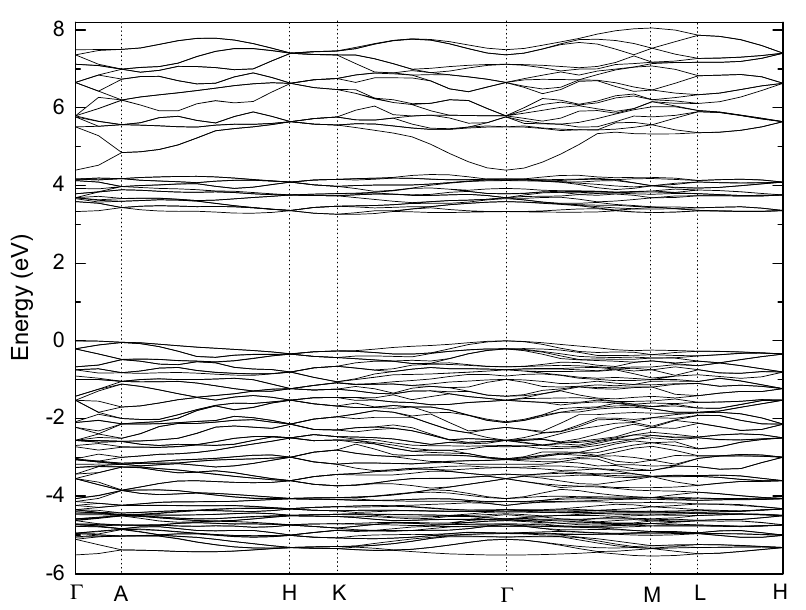
Figure 3. The band structures of LiNbO 3 -type ZnTiO 3 along the high symmetry directions in the Brillouin zone based on norm-conserving pseudopotentials within